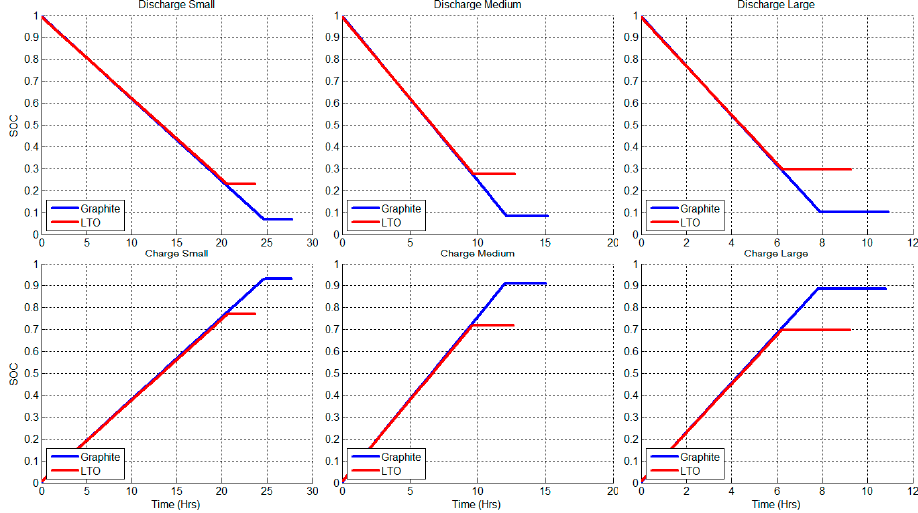
Figure 5. State of charge (SOC) comparison of graphite and LTO half-cell simulations of 0.045 C, 0.089 C, and 0.13 C cycles.